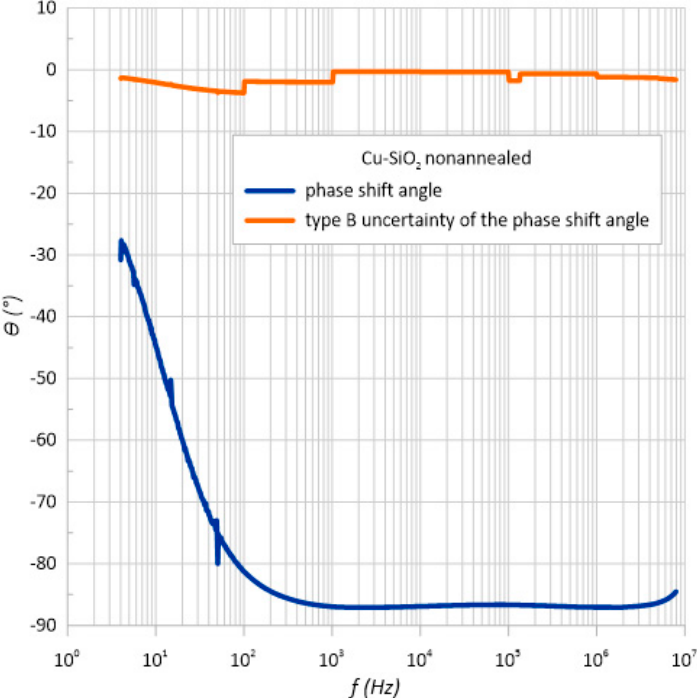
Figure 14. Frequency dependence of the impedance and standard impedance uncertainty of meas- urement type B u( θ ) of the unheated structure.